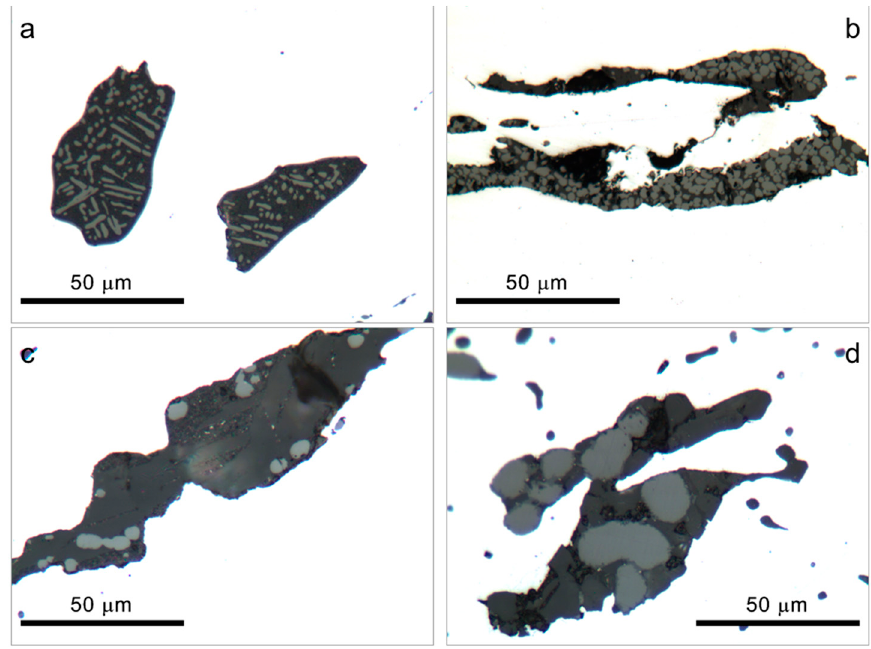
Figure 6. Inclusions observed by optical microscopy on nonetched cross-sections of the San Carlone iron samples and the reference sample of puddled iron. ( a ) Sample 44—slightly corroded sample in contact with copper; ( b ) Sample 46—slightly corroded sample not in contact with copper; ( c ) Sample 87—heavily corroded sample in contact with copper; and ( d ) Sample A—reference sample of puddled iron.